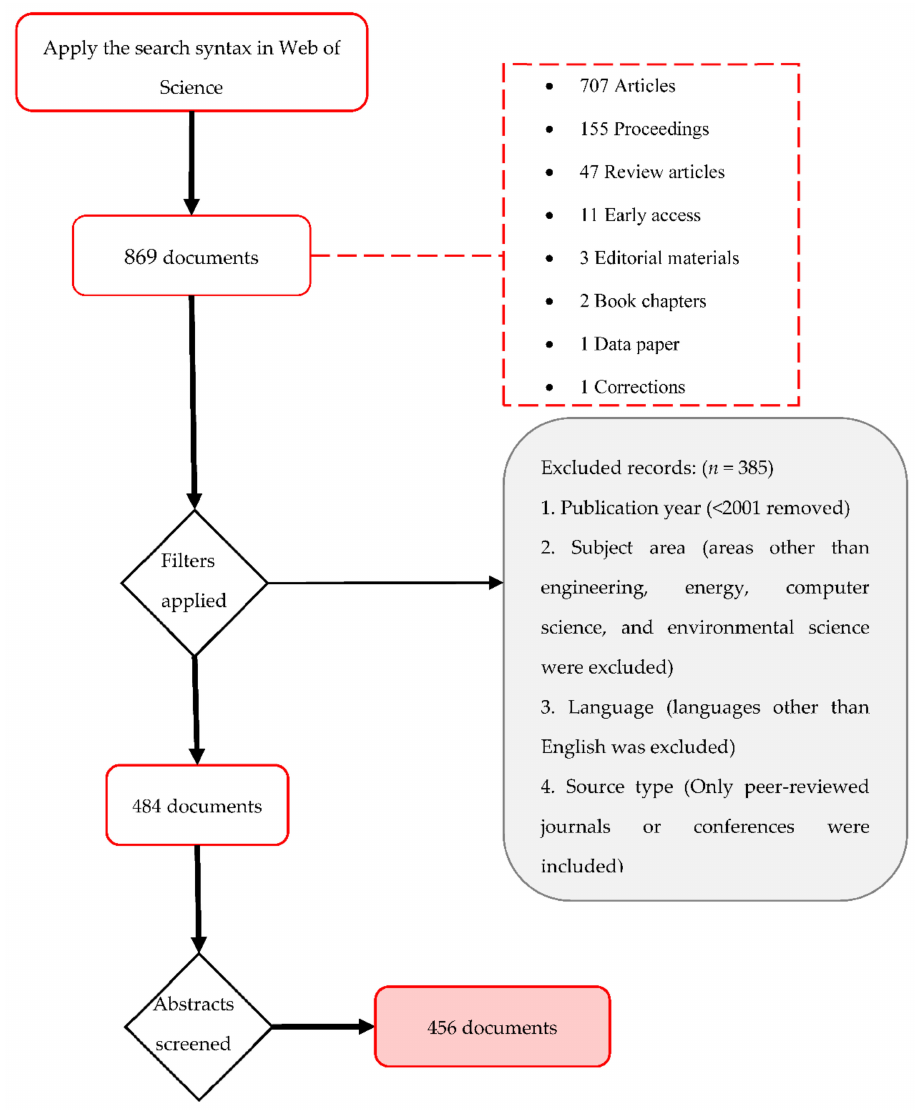
Figure 1. Database development